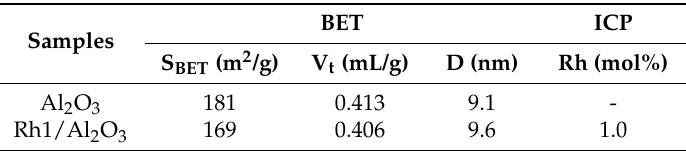
Table 1. BET (Brunauer–Emmett–Teller) specific surface area (S BET ), total pore volume (V t ), and average pore diameter (D), as well as ICP-OES (inductively coupled plasma - optical emission spectroscopy) data of support and